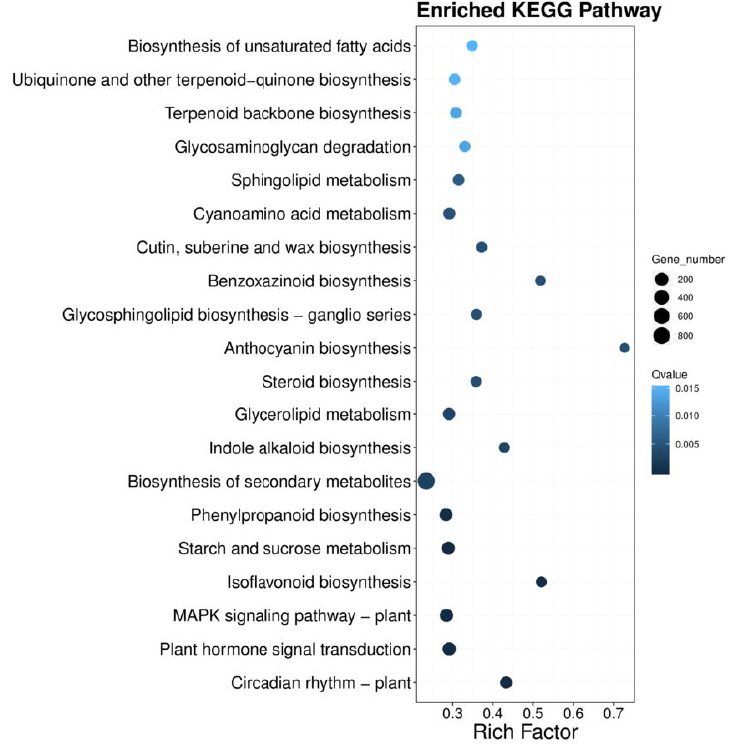
Figure 4. KEGG enrichment of differentially expressed genes under drought conditions. The y -axis represents the KEGG pathway, and the x -axis represents the enrichment factor. A high q-value is expressed by light blue, whereas a low q-value is represented by dark blue.